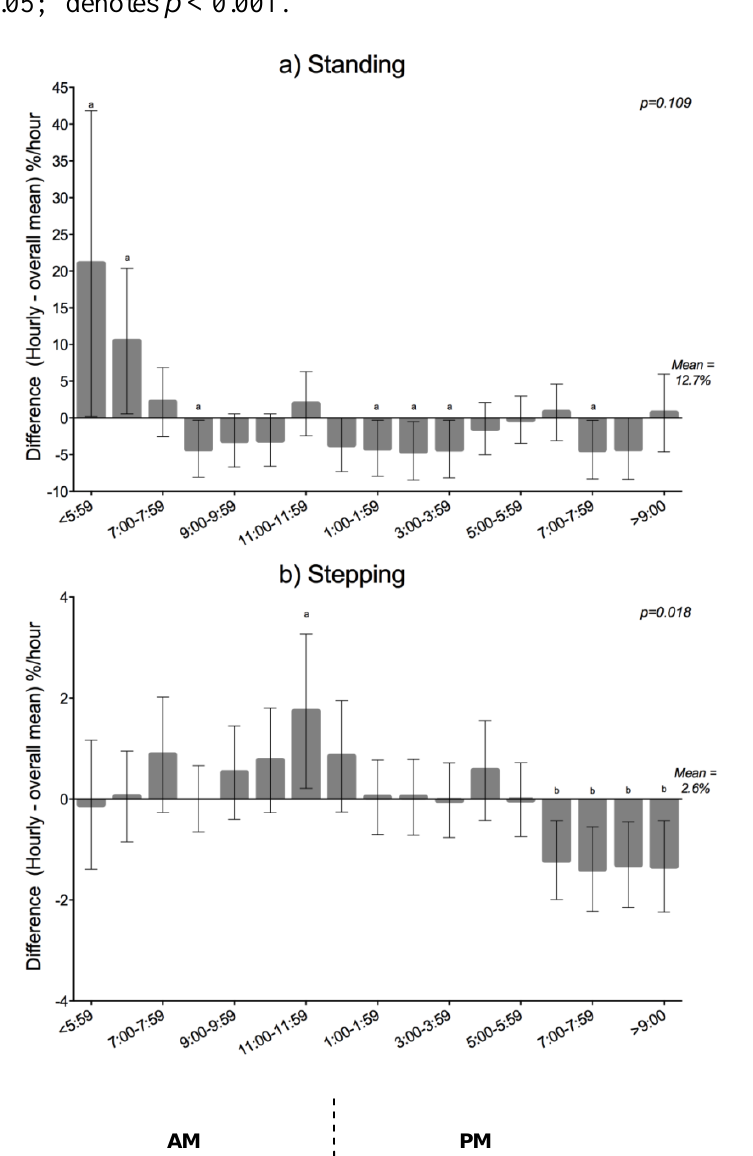
Figure 3. Average (mean, 95% CI) percent of time each hour spent ( a ) Standing, and ( b ) Stepping compared to the overall mean percentage in 31 adults in residential aged care. Depression and falls were entered as significant covariates in both models. The standing time analysis further included age, gender, cognitive impairment, and mobility as covariates. Note: 9 = 09:00 to 09:59 AM, <5:59 AM all collapsed and 9 PM+ all